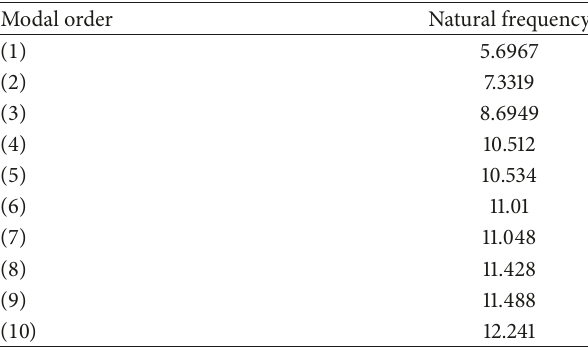
Table 7: Natural frequencies of the new structure.